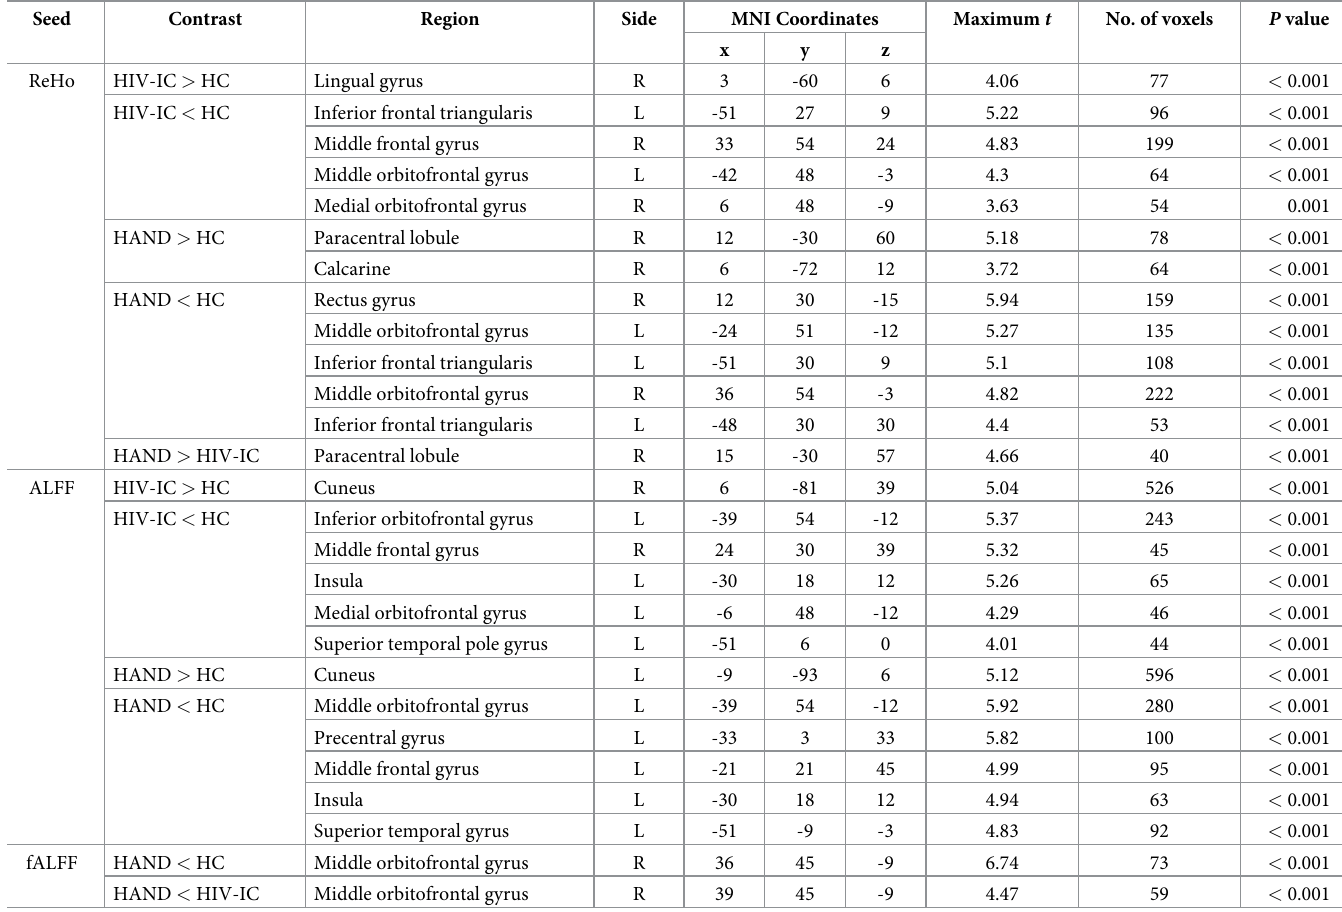
Table 2. Regions showing significant differences in rsfMRI values between the